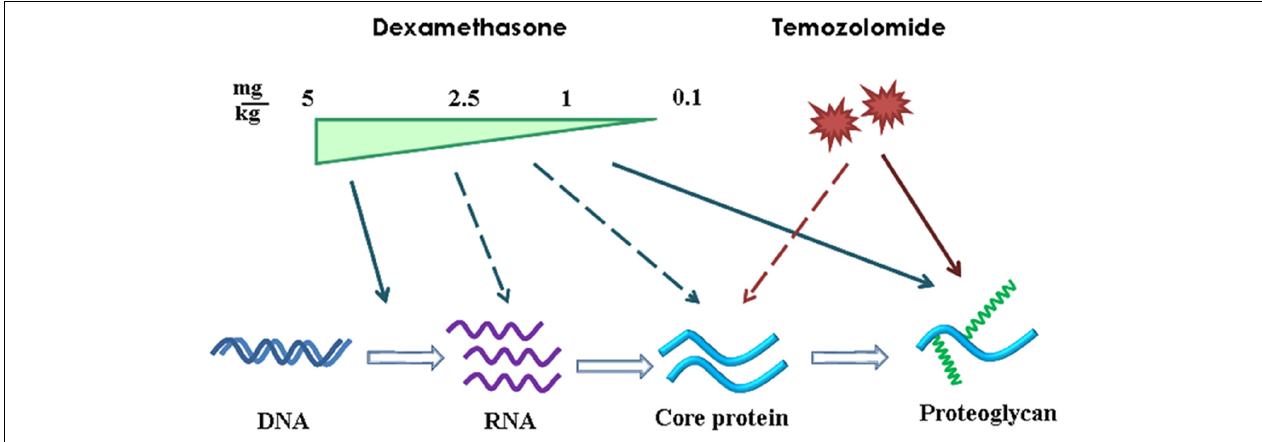
FIGURE 7 | Schematic representation of the effects of DXM and TMZ onto PGs expression and content in normal rat brain tissue in the experimental system in vivo . Arrows–significant effect and dotted arrows–weak